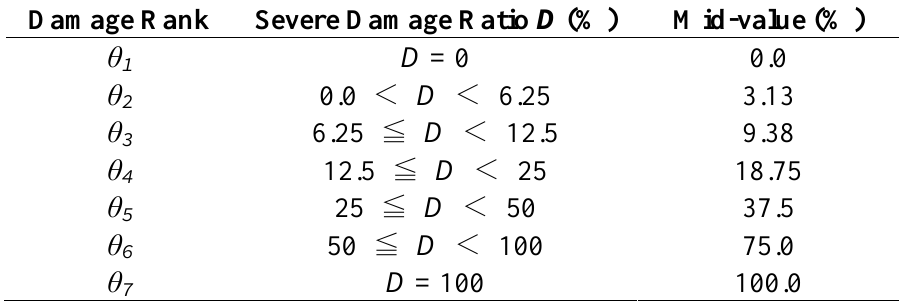
Table 1. Range of severe damage ratios and mean values for each damage severity ranking.